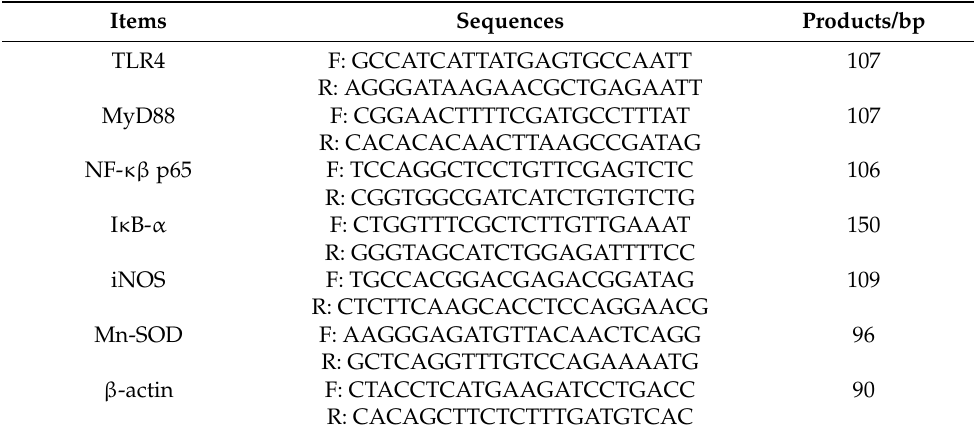
Table 4. Sequence information on the primers used for quantitative